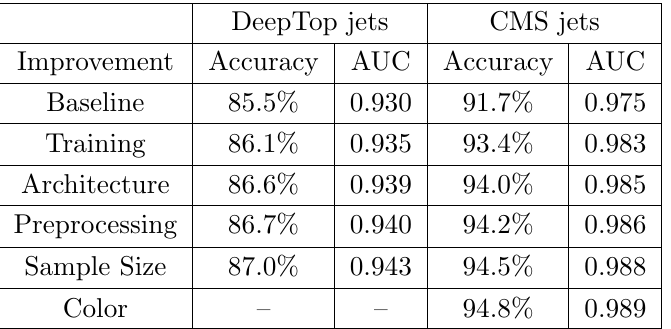
Table 3 . Accuracy and area under the curve (AUC) of our tagger after adding the modi(cid:12)cations over DeepTop